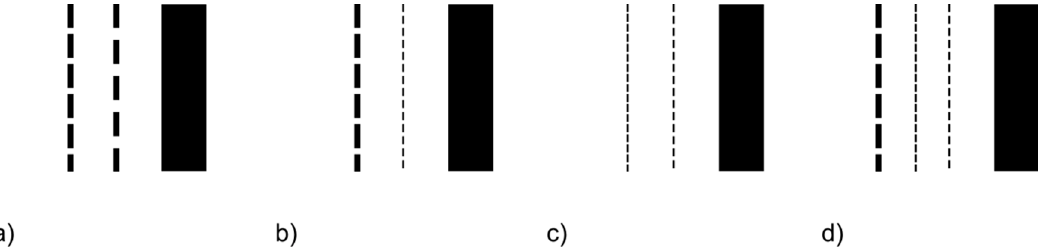
Figure 3. Schematic configuration of the different samples under investigation: ( a ) double leaf perforated panels (PP); ( b ) double leaf one perforated panel and a micro-perforated membrane (PP-MPM); ( c ) double leaf double micro-perforated membranes (MPM-MPM); ( d ) triple leaf optimized triple-layer absorber (PP-MPM-MPM). Black box represents the rigid surface.